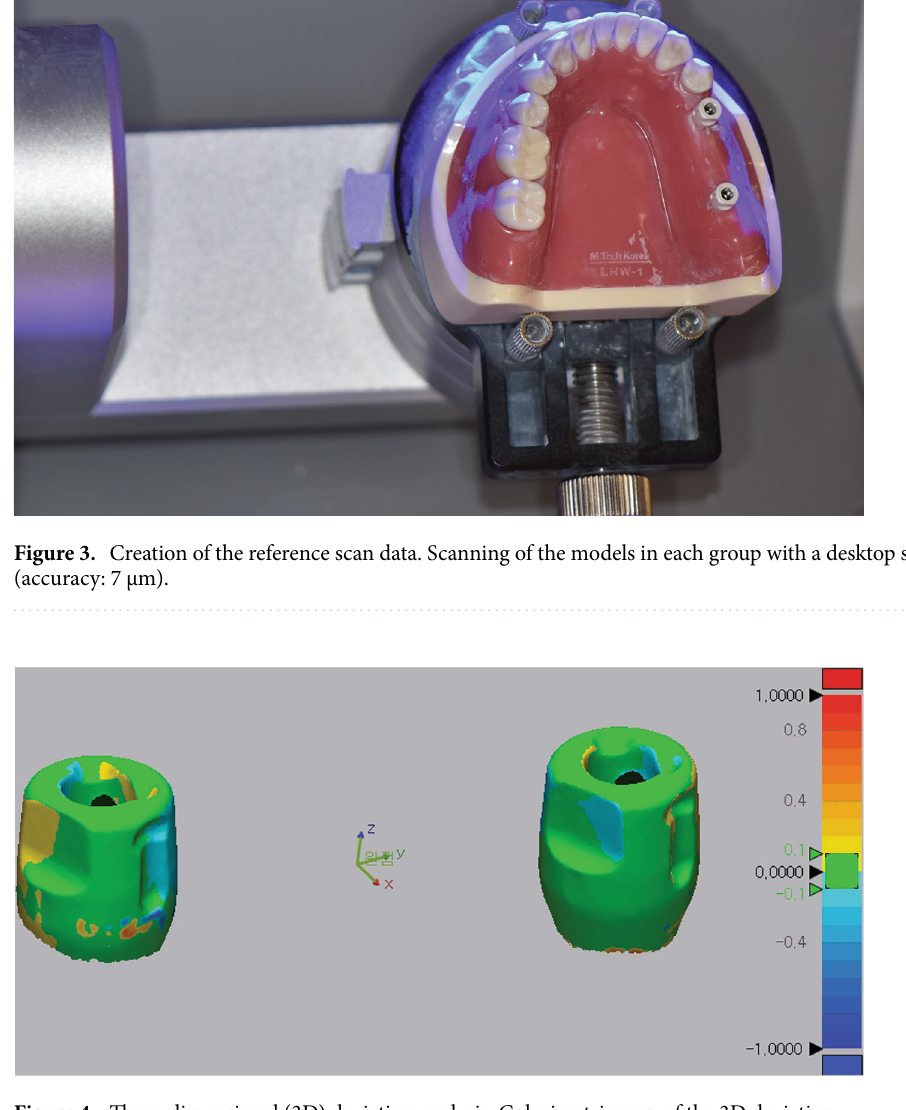
Figure 4. Three-dimensional (3D) deviation analysis. Colorimetric map of the 3D